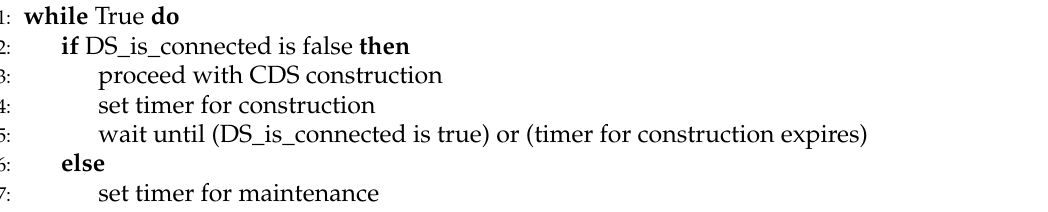
Algorithm 8 CDS